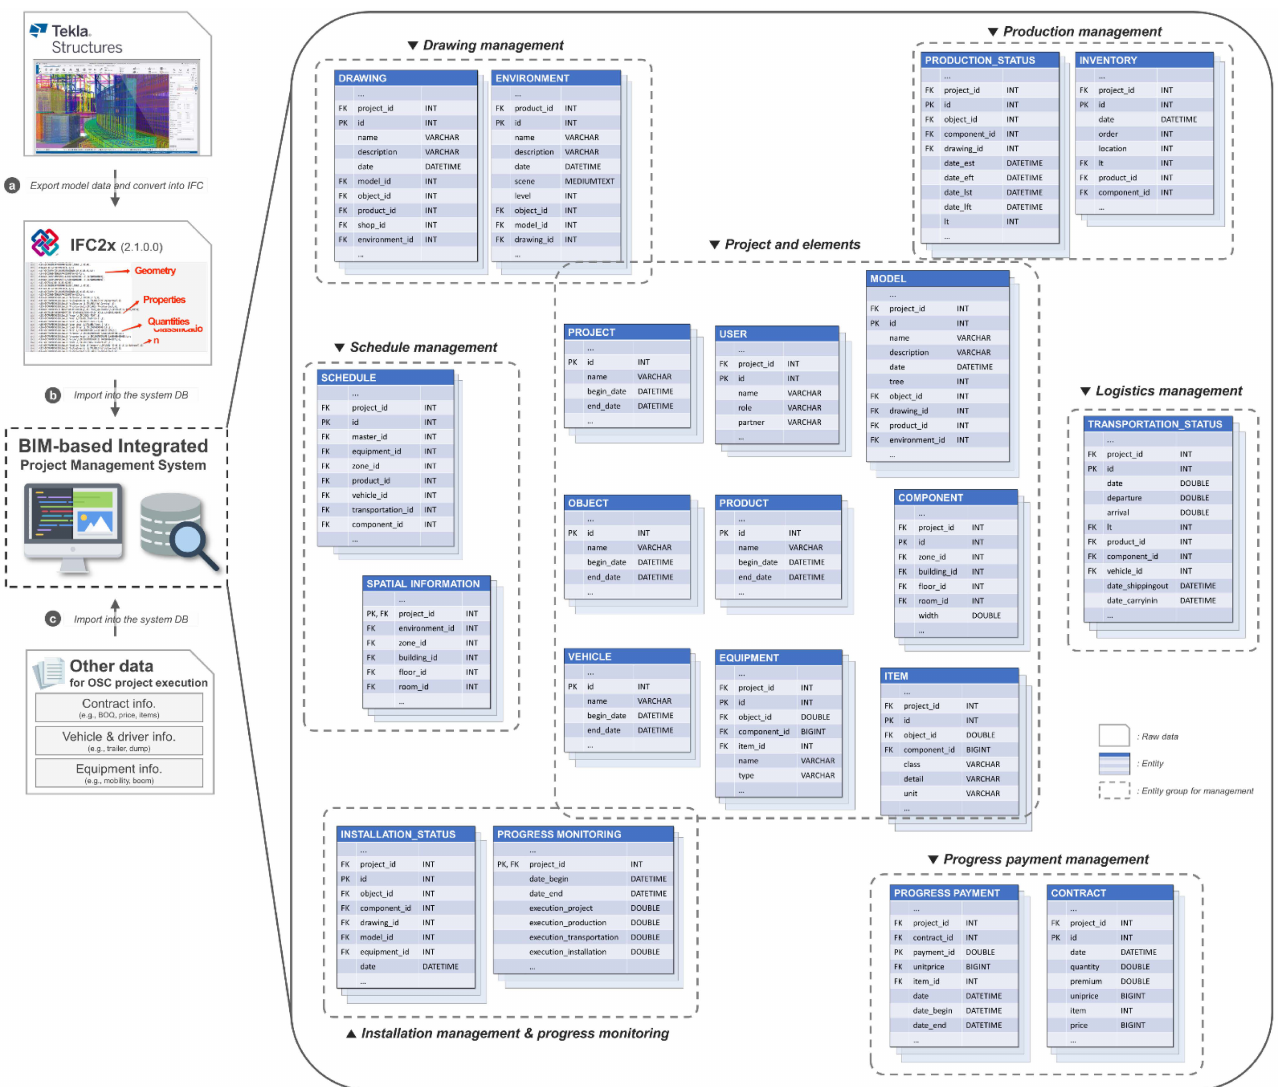
Figure 2. Entity relation diagram of the